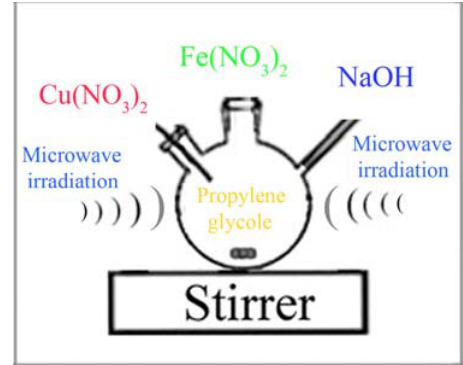
Fig. 1 . Schematic diagram of preparation of